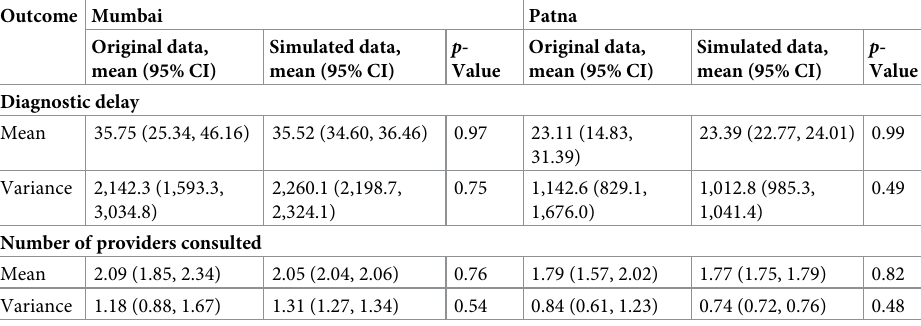
Table 8. Model validation: Comparison of original data and simulated pathways.